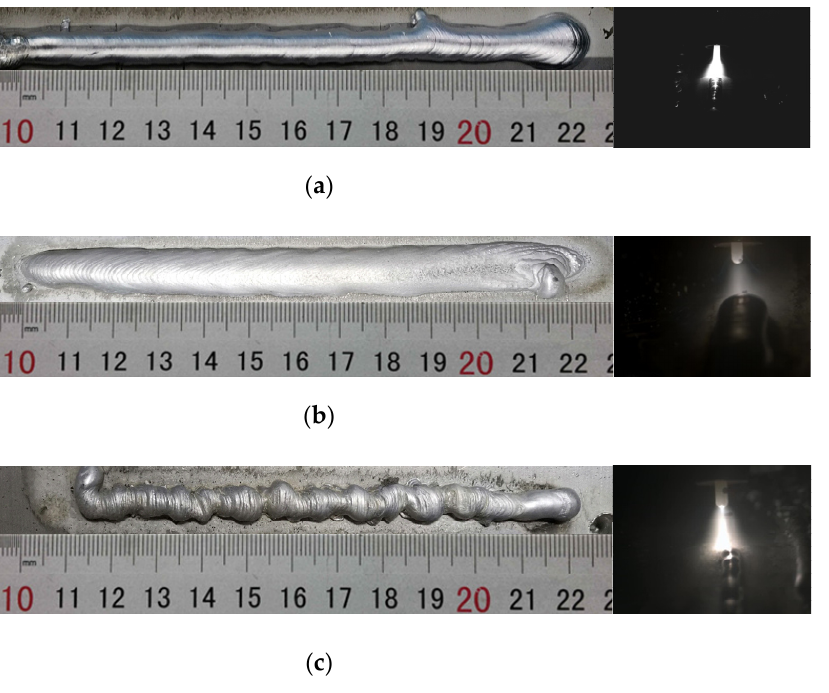
Figure 4. The macroscopic morphology of common defects. ( a ) Lack of fusion ( Ip ≤ 200 A or Tb ≤ 220 ◦ C); ( b ) overflow ( Ip ≥ 280 A or Qv ≥ 200 mm 3 /s); ( c ) discontinuity ( Ts ≥ 30 mm/s).